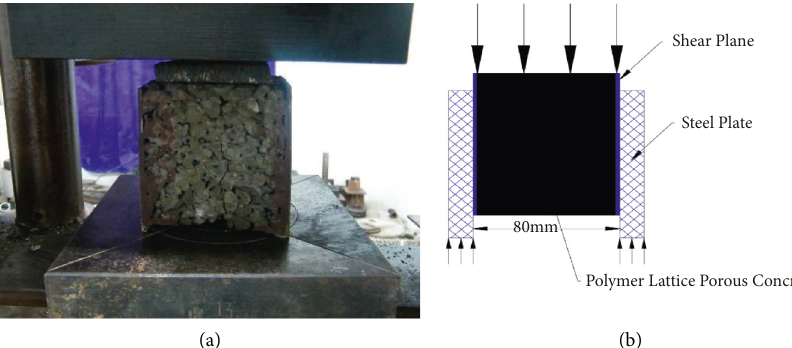
Figure 3: Loading device and diagram of the shearing test for the steel plate and polymer-modified cement lattice concrete interface. (a) Test device. (b) Loading